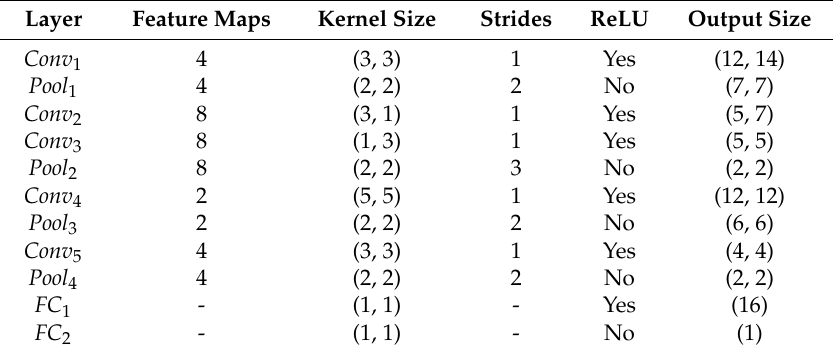
Figure 7. Structure of DCCNN. Bt: batch size, Ch: channel count, Input: input layer, Conv: convolution layer, Pool: pooling layer, Flatten: flatten layer, and FC: fully connected layer. Table 3. Structural parameters of